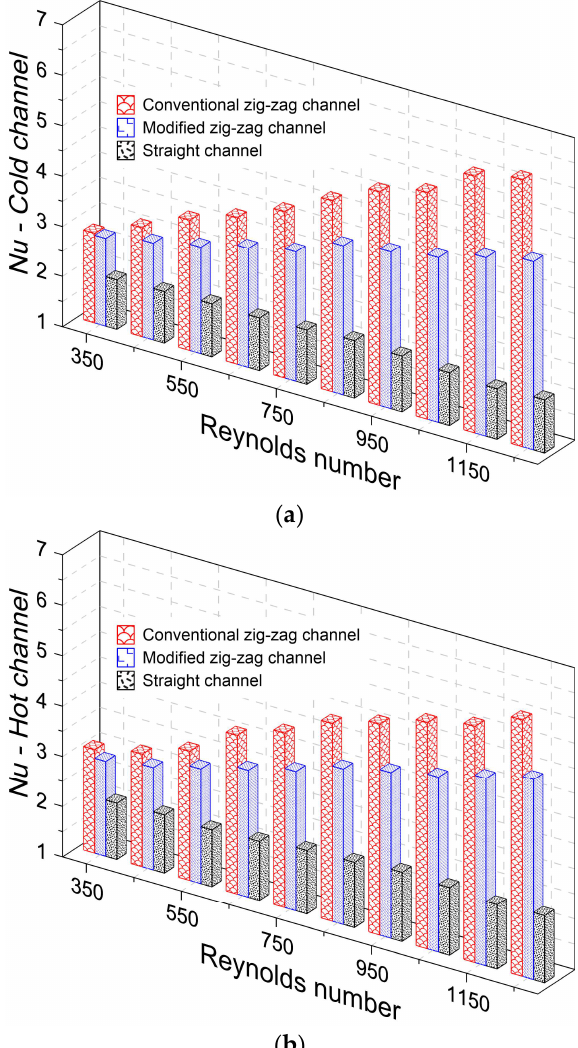
Figure 9. Nusselt number for the different channel configurations: ( a ) cold channel; ( b ) hot chan- nel.